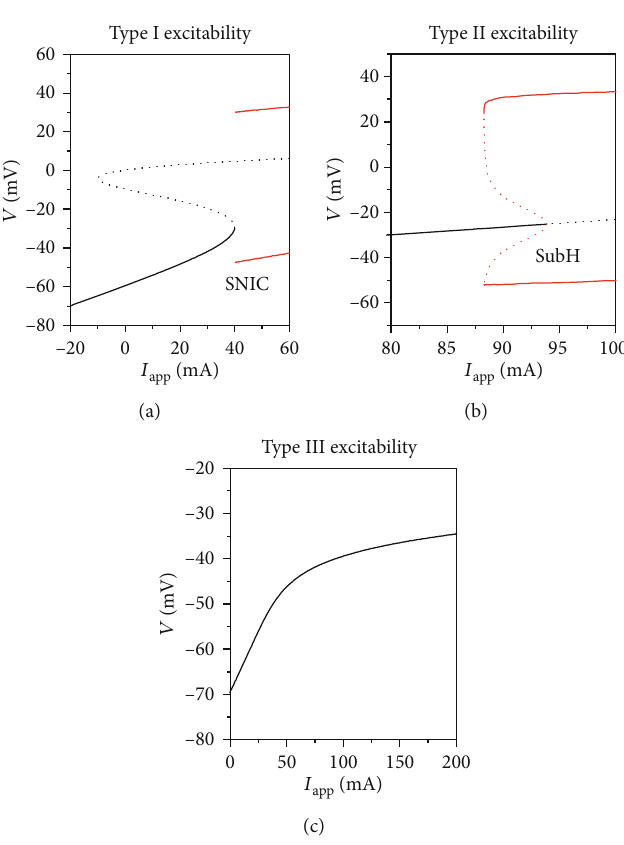
Figure 12: Bifurcations for three types of excitability. Black solid curve represents the stable steady state, black dotted curve represents the unstable steady state, red solid curves represent stable limit cycle, and red dotted curves represent the unstable limit cycle. (a) Type I excitability. The SNIC represents the saddle-node bifurcation on an invariant cycle. (b) Type II excitability. The SubH represents the subcritical Hopf bifurcation. (c) Type III excitability. No bifurcations or stable fi ring